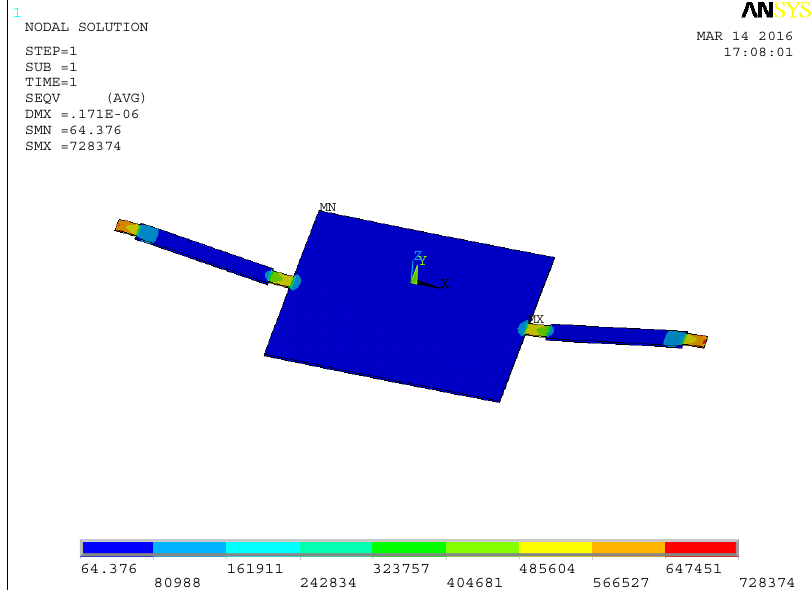
Figure 7. Stress distribution diagram.